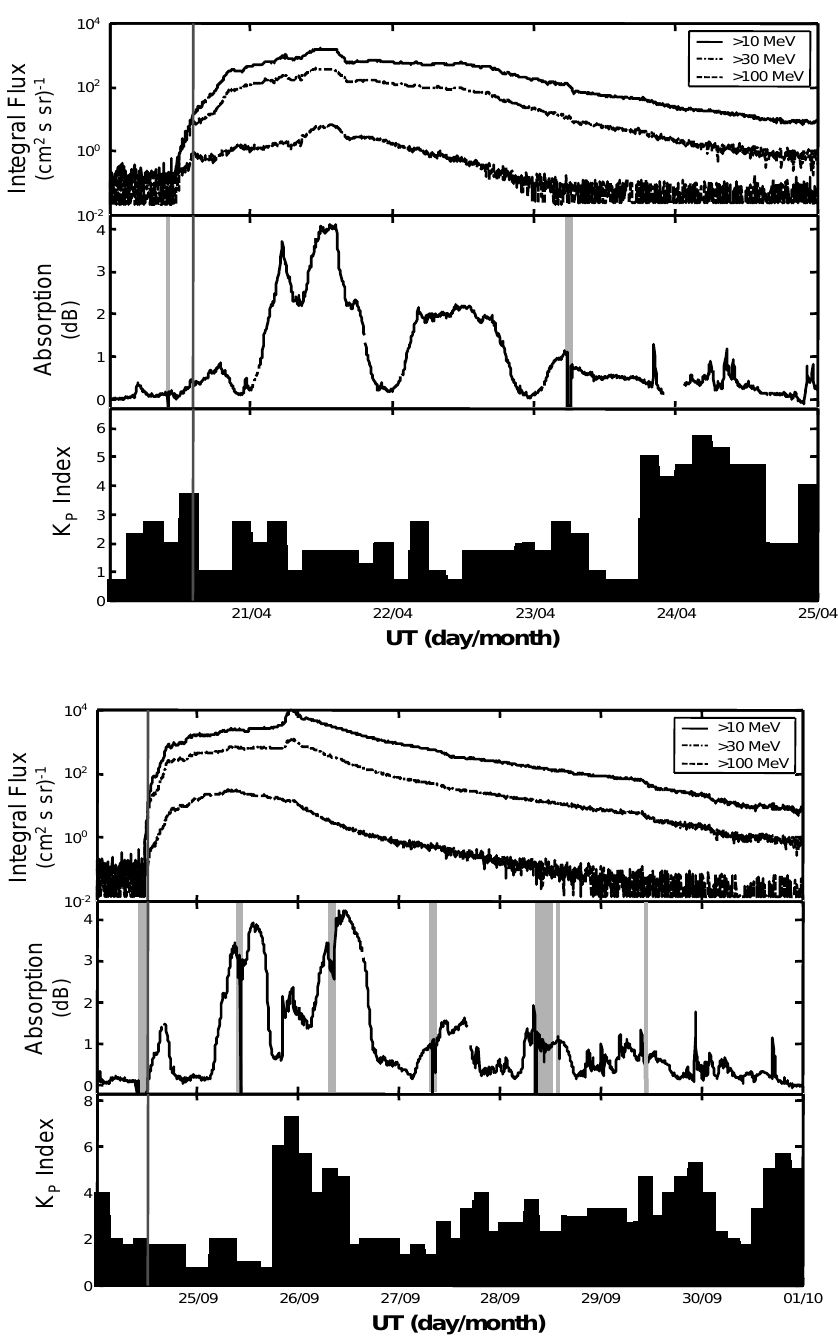
Fig. 3. Example of a PCA event from September 2001, in the same format as Fig. 2. Note the increase in K p late on 25 September when a CME im- pacted the magnetosphere; this is re- flected in the absorption data as a sharp rise shortly before midnight. At the same time the lower two energy chan- nels from GOES-8 display increases in flux as the interplanetary shock acceler- ates the protons. Note that the absorp- tion is more variable during this event, plus there are negative spikes and bays around local noon on each